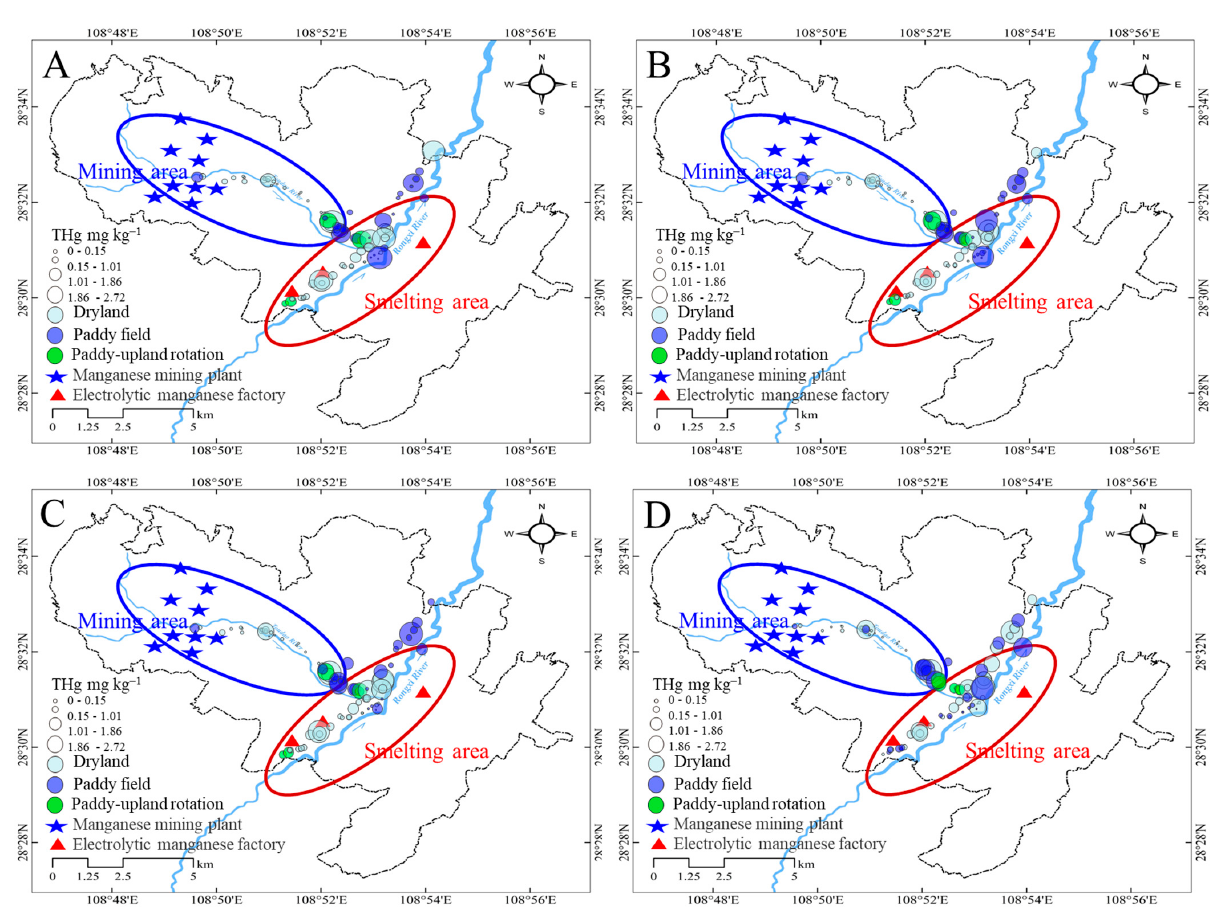
Figure 2. Spatial distribution of total Hg in different soil profiles in the farmlands at mining and smelting areas ( A ): 0–10 cm, ( B ): 10–20 cm, ( C ): 20–30 cm, and ( D ): 30–40 cm.